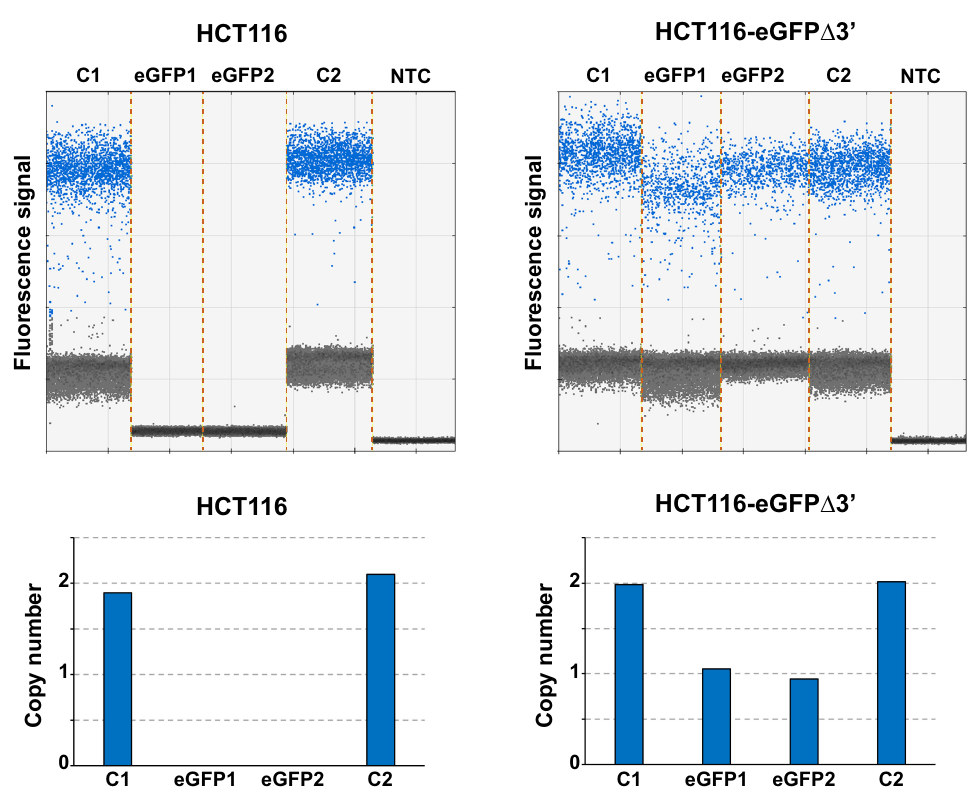
Fig 3. Determination of eGFP Δ 3’ copy number by ddPCR. Upper graphs depict droplets fluorescence intensity for the indicated reactions using genomic DNA from either parental HCT116 cells or the HCT116-c reporter cell line. NTC stands for “no template control”. Blue specks denote droplets classified as positive. Black specks denote droplets classified as negative. The bar-plots below show eGFP Δ 3’copy number values in parental HCT116 cells or the HCT116-eGFP Δ 3’ reporter cell line. Control amplicons were selected in diploid regions and the copy number was set to 2.